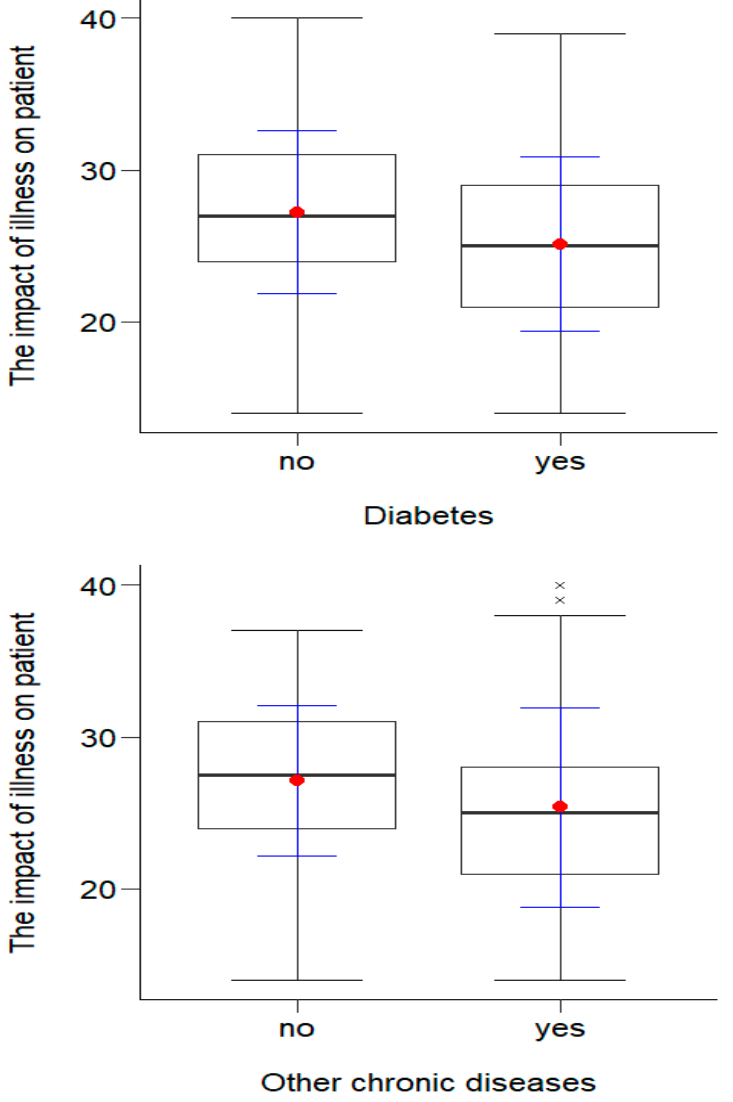
Figure 3. Effects of clinical variables on the impact of illness on the patients.